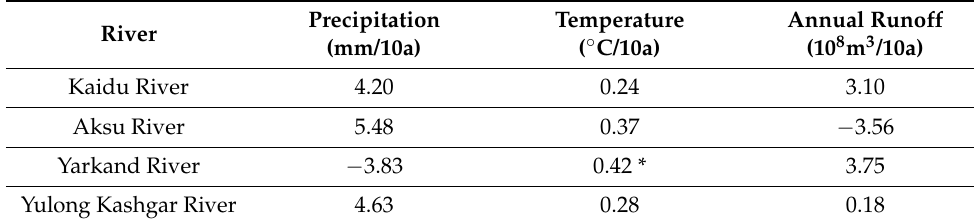
Table 2. Ten-year change rates of precipitation, temperature and annual runoff, and their significance of major rivers in the